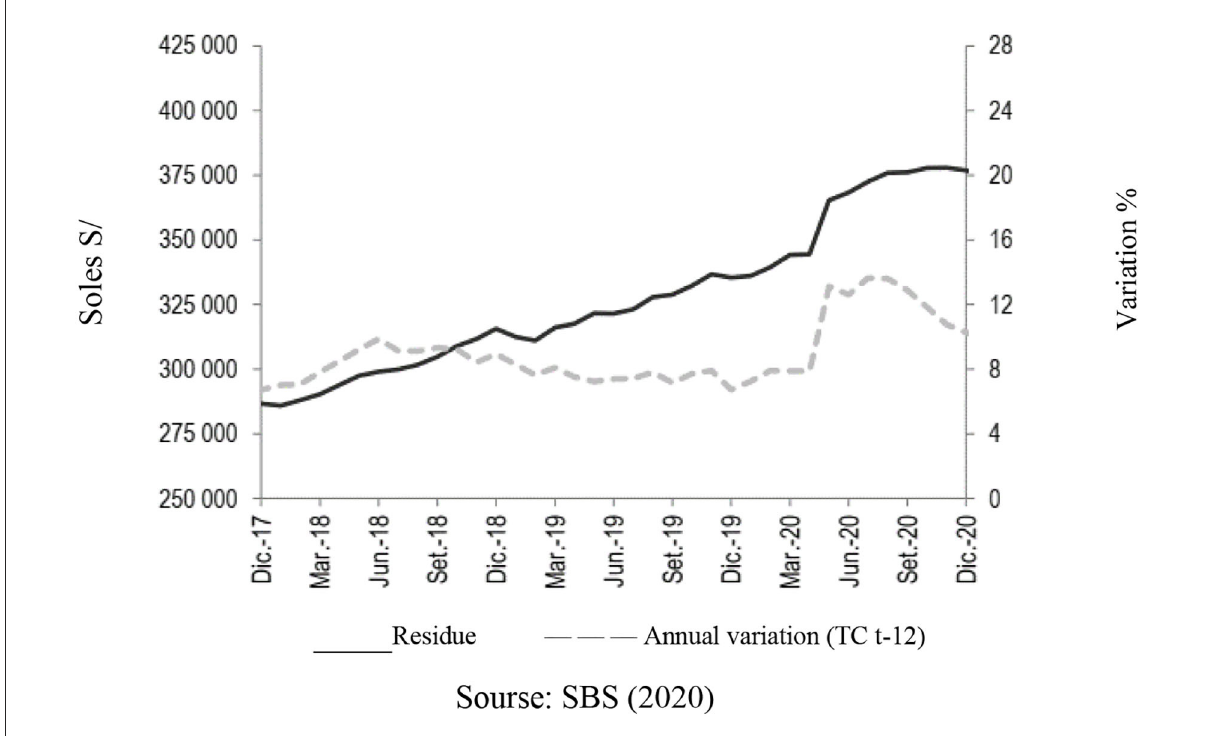
FIGURE1 Financial system: direct credits. Source: SBS (2020).